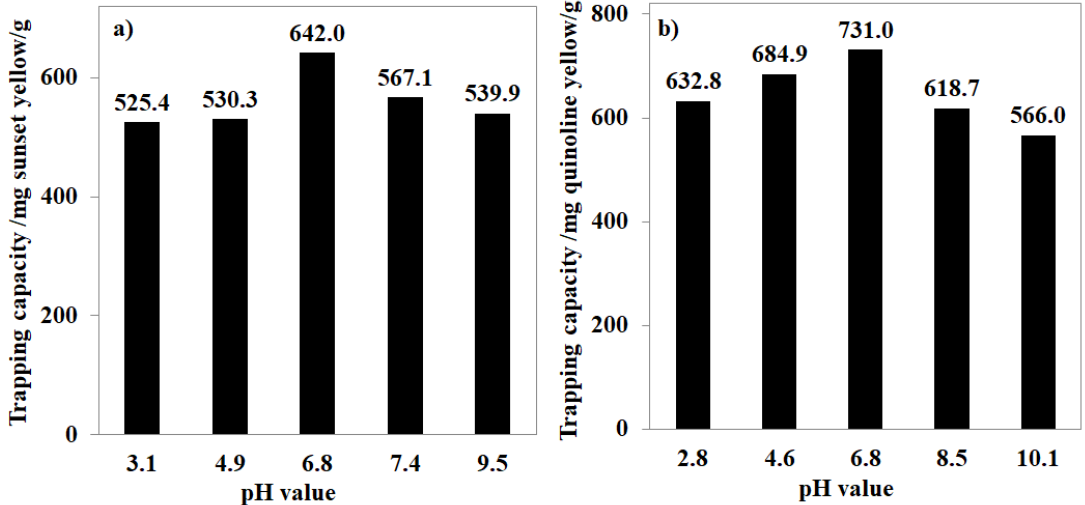
Figure 9. Effect of pH on sunset yellow ( a ) and quinoline yellow ( b ) trapping capacity of MOF-808_300 at 30 °C.